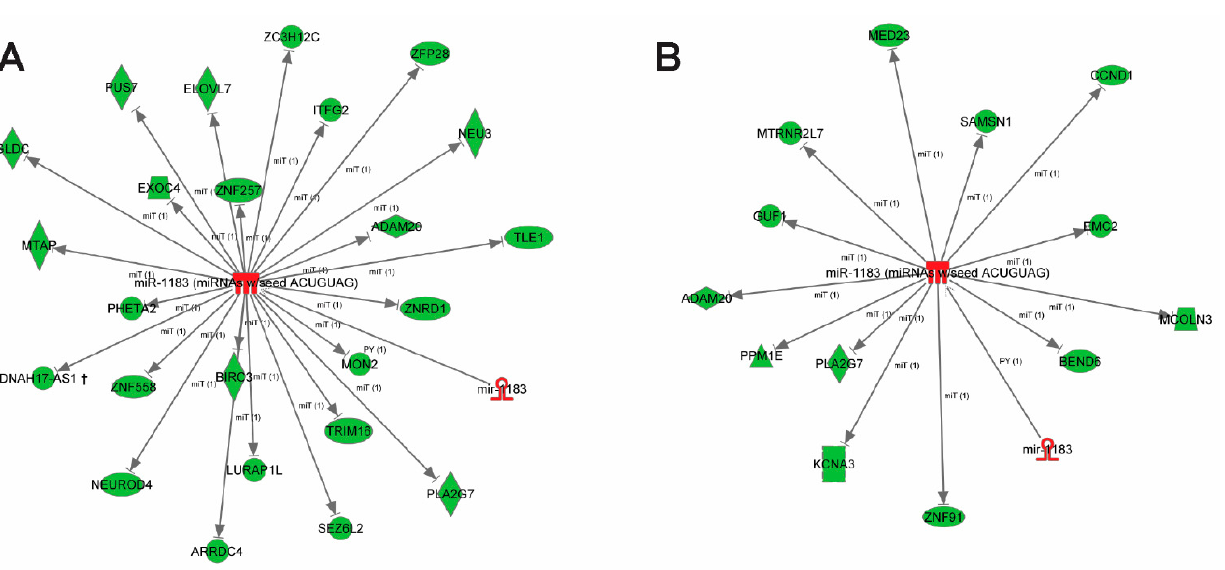
Figure 5 . MicroRNA–mRNA network displaying the direct regulation of target genes by miR-1183. Up-regulation of miR-1183 and down-regulation of target genes following ( A ) tachycardia and ( B ) stretch. ( C ) Commonly regulated miR-1183 and target genes ADAM20 and PLA2G7 . Ingenuity ® Pathway Analysis, n = 4 – 5 hearts per group. 3. Discussion Our results show that the pathological triggers, stretch and tachycardia, induced largely independent early remodeling responses in human atrial myocardium. Both trig- gers shared only a small common fraction, but, within this fraction, the pri-microRNA encoding transcript, MIR1183, was the strongest up-regulated for both on genome-wide